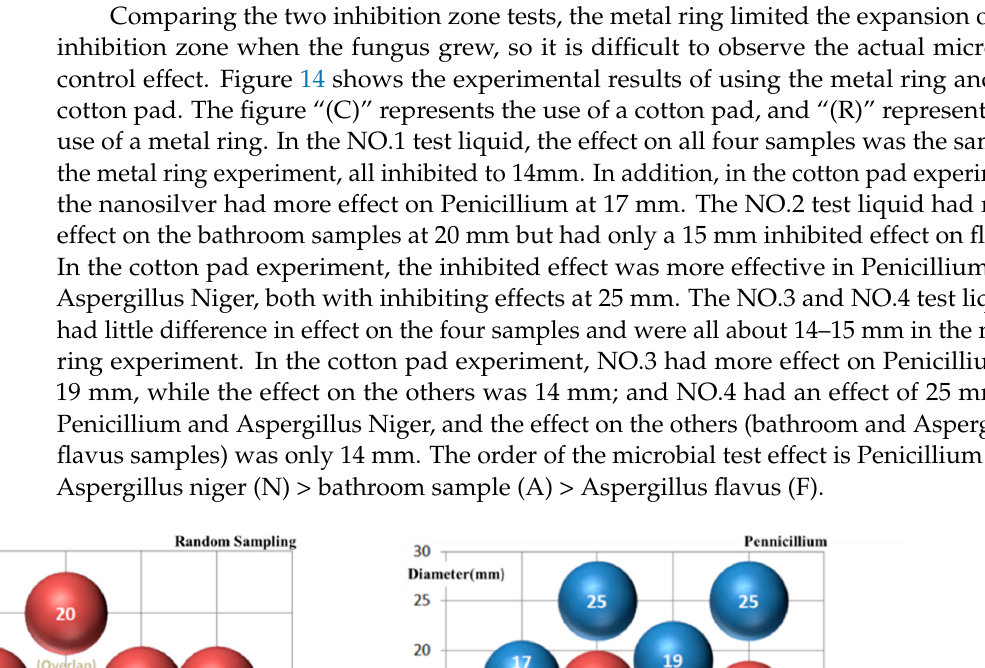
( d ) Figure 14. Comparison of microbial control tests: ( a ) bathroom sample; ( b ) Penicillium; ( c ) Asper- gillus niger; ( d ) Aspergillus Flavus. 4. Conclusions There are two ways to fabricate nanoparticles: one is physical (the “bottom-up”), and the other is a chemical (the “top-down”) technique. The chemical method uses chemical agents, which is not environmentally friendly. In addition, other physical methods con- sume energy/time and cannot instantly monitor the process. This study developed a real- time monitoring system for the Electrical Spark Discharge Method (ESDM) using a micro- Electrical Discharge Machine. This study has two limitations. One is that the ESDM is a physical method and, unlike the chemical way, cannot obtain the precise size and concen- tration of the nanoparticle. The other is that the inhibition of Niger cannot obtain a precise concentration but a relative one. However, all the experiments in this study were con- ducted with a standardized process in order to reduce the errors made by the human hand. With this system, the micro-EDM can obtain the successful discharge times, elec- trode energy consumption, and discharge success rate. The conclusions of this study are as follows: 1. The user may adjust the successful discharge times, electrode energy consumption, and discharge success rate at any time to obtain the optimal parameters to fabricate the nanosilver colloid using the Electrical Spark Discharge Method. 2.